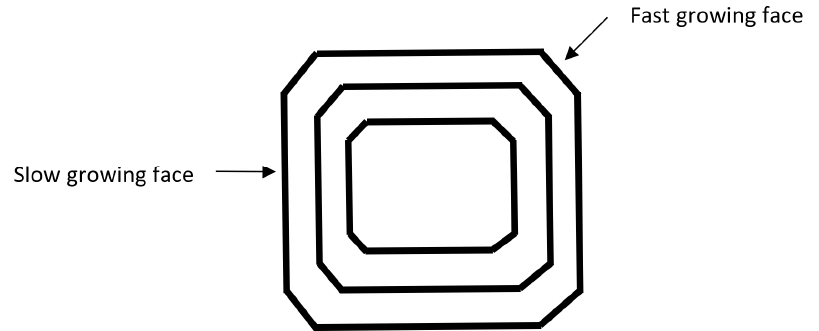
Figure 1. Relative growth rates as a crystal